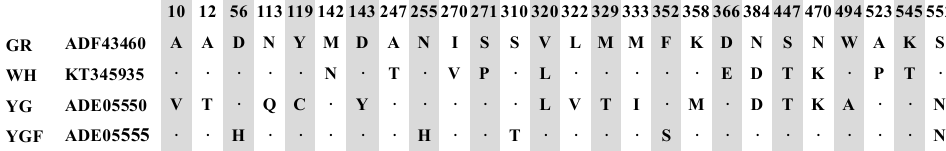
F igure 2. Comparison of amino acid differences of 001D from H. armigera between the WH, GR, YG, and YGF strains (GenBank ® accession numbers KT345935, ADF43460, ADE05550, and ADE05555). Amino acids the same as that of the GR strain are indicated with a dot. Numbering indicates the alignment number of different residue amino acids.